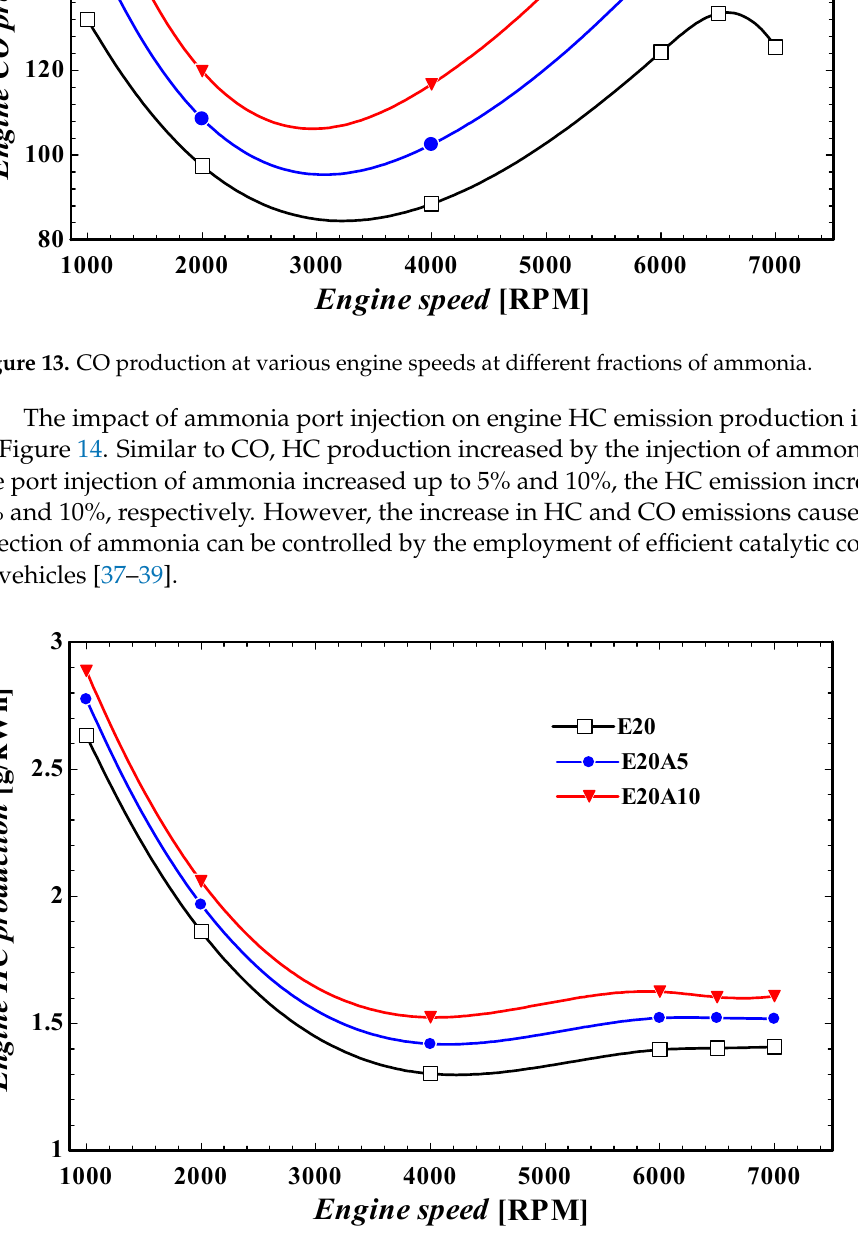
Figure 14. HC production at various engine speeds at different fractions of ammonia.